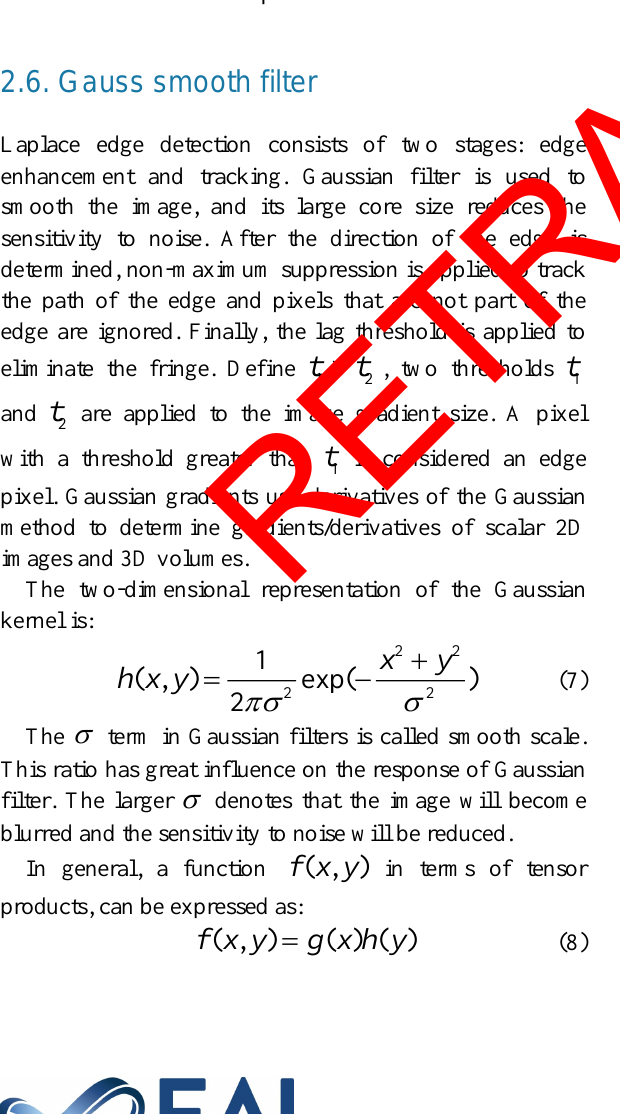
Figure 3. Extension template of Gauss-Laplace